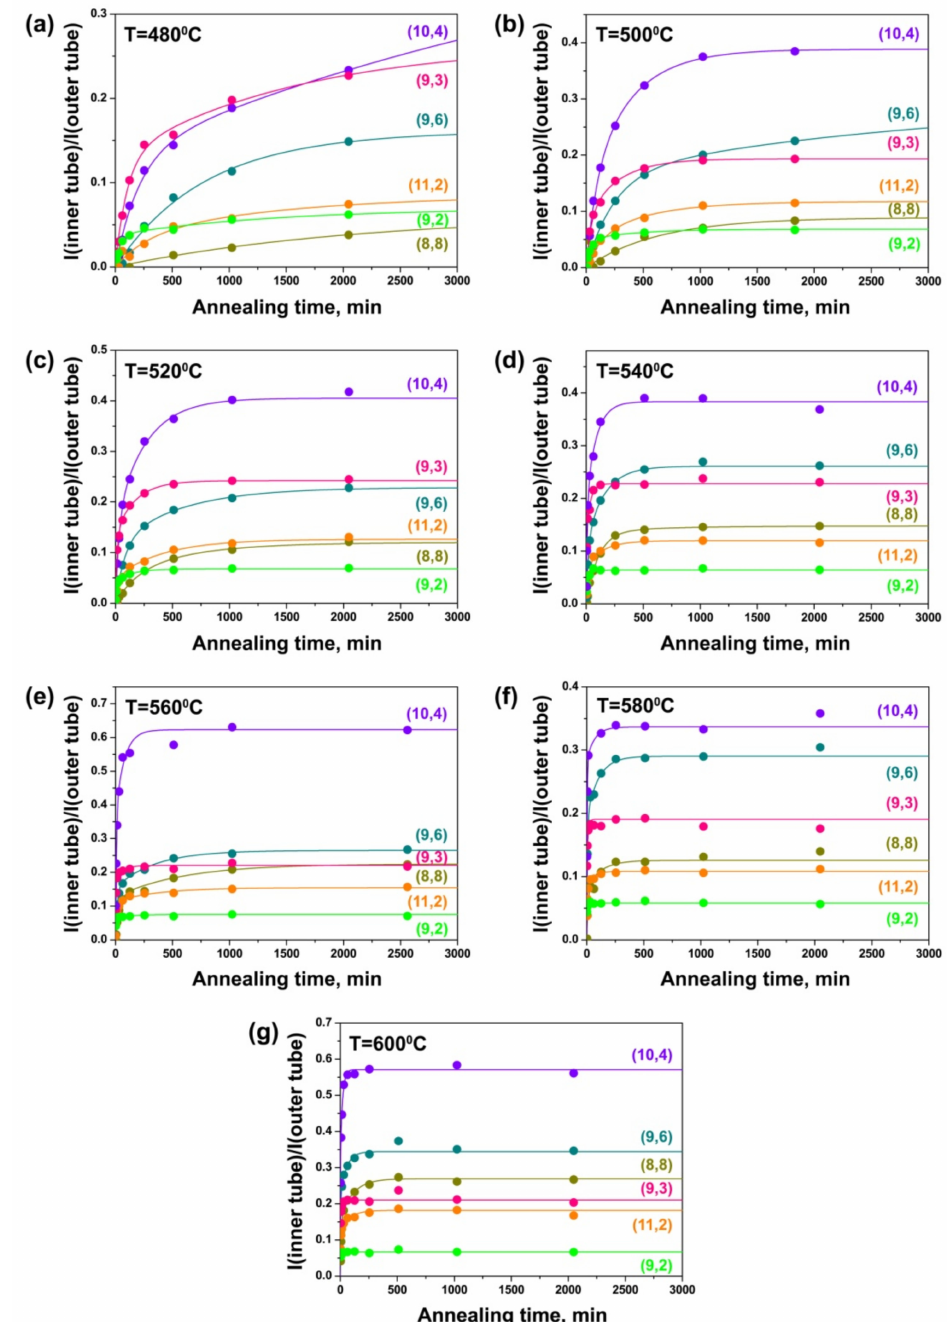
Figure 9. The integral intensity of peaks of the (8,8), (9,6), (10,4), (11,2), (9,3) and (9,2) inner tubes normalized to the intensity of the outer tube peak observed in the RBM-band of Raman spectra of the annealed NiCp 2 -filled SWCNTs acquired at a laser wavelength of 568 nm (E ex = 2.18 eV) plotted versus annealing time. The experimental data for the samples annealed at temperatures of 480 ◦ C ( a ), 500 ◦ C ( b ), 520 ◦ C ( c ), 540 ◦ C ( d ), 560 ◦ C ( e ), 580 ◦ C ( f ) and 600 ◦ C ( g ) are shown as filled circles. The fitting results of the data are presented as solid